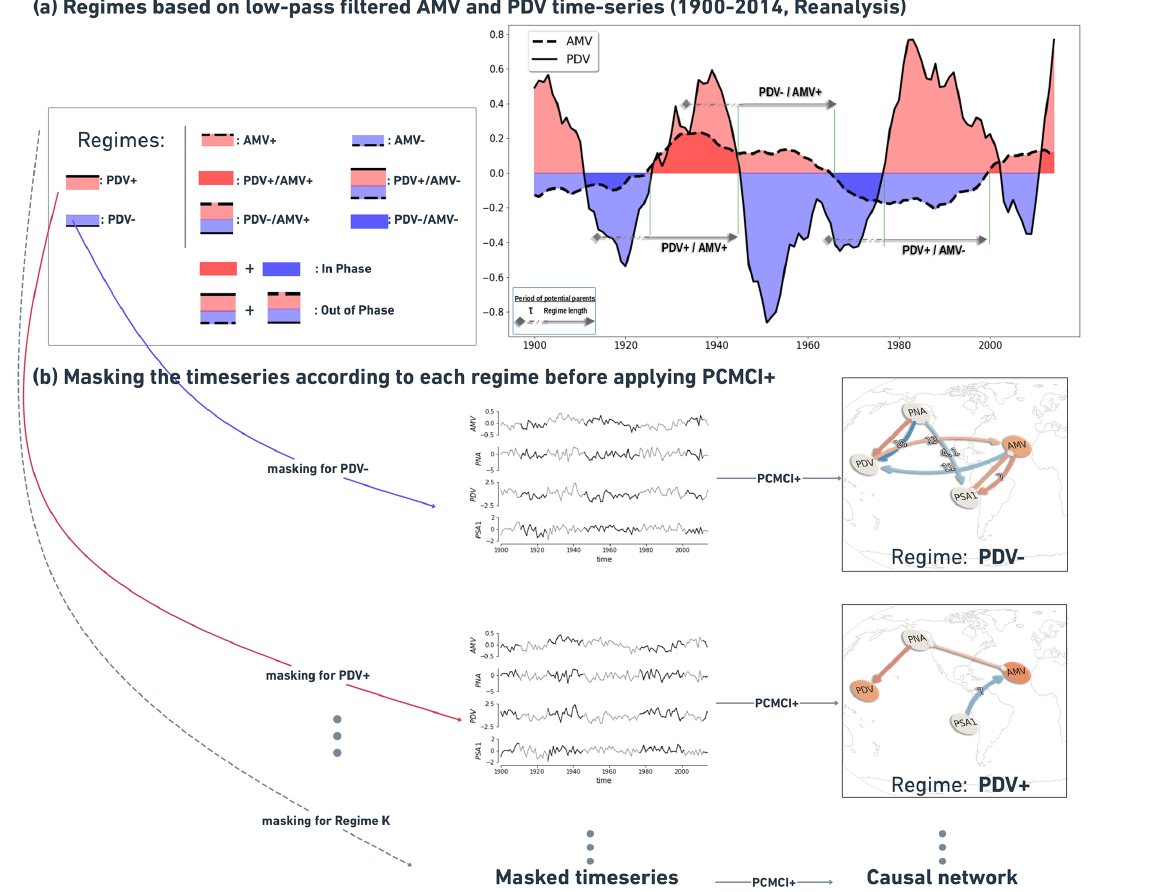
Figure 3. (a) PDV and AMV time series calculated by CVDP-LE diagnostics on ERSSTv5 data are smoothed using 11-year and 13-year low-pass filters, respectively. A total of 10 regimes are defined (see table on the left) in addition to the 1900–2014 complete period. The PCMCI + algorithm is applied to unfiltered (non-smoothed) PDV, AMV, PNA and PSA1 yearly detrended time series that are masked according to the periods that define each regime. The right arrows on the smoothed time series represent unmasked periods from 3 out of 10 regimes (PDV + /AMV + , PDV − /AMV + and PDV + /AMV − ). (b) The regimes identified in (a) are used to mask the non-smoothed (but detrended) index time series before applying PCMCI + . Here, for example, we show how we mask the data according to the PDV − (top) and PDV + (bottom) regimes. The gray shaded periods are masked and thus not considered during the PCMCI + analysis. Note that the masking here refers to variables at time point X j t , while their lagged parents can also originate from a masked period (gray shaded). This setting is referred to as mask_type='y' in Tigramite. Consequently, applying PCMCI + to differently masked time series produces different causal networks (network in top vs. network in